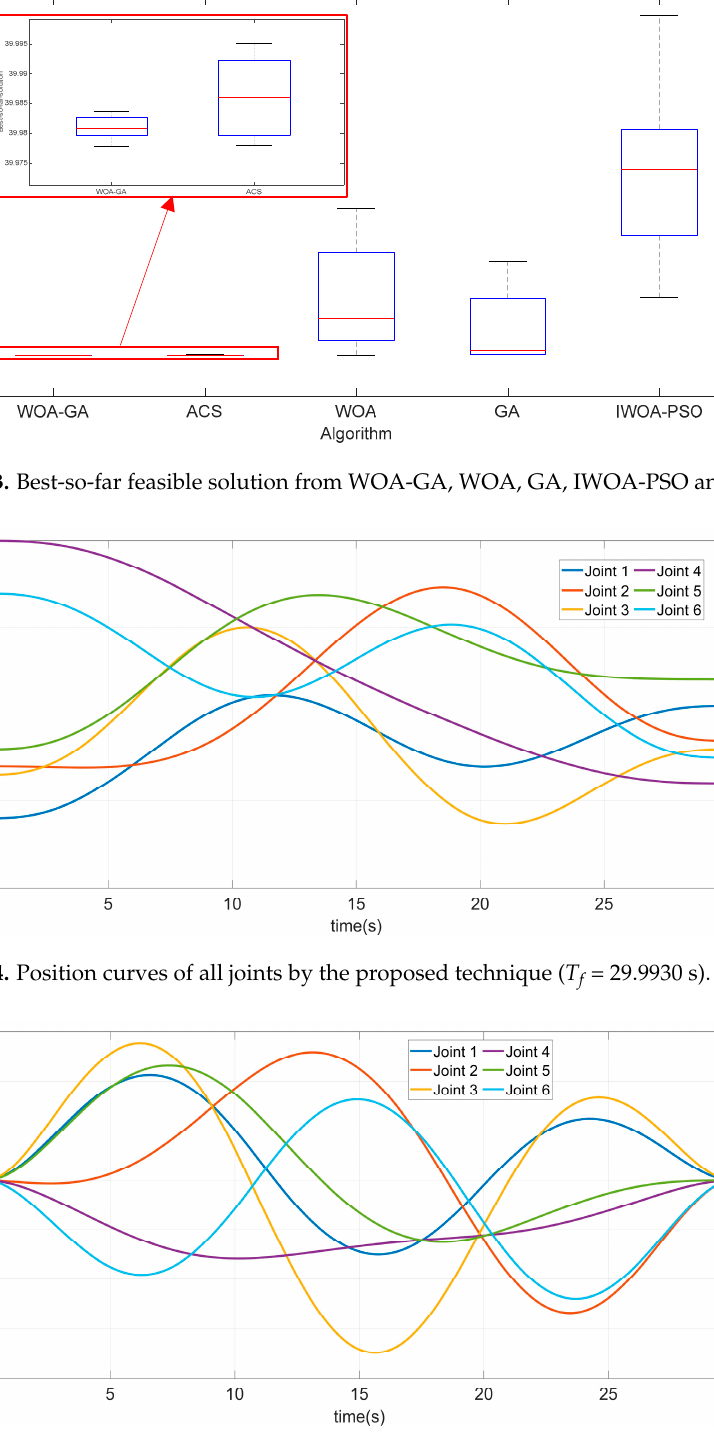
Figure 5. Velocity curves of all joints by the proposed technique ( T f = 29.9930 s).